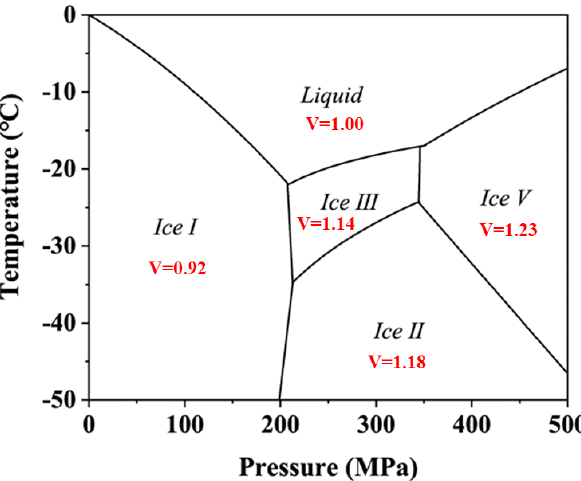
Figure 1. The volume of ice crystals (pure water) in individual phases; the letter V in the figure is the corresponding volume of different phases (g/cm 3 ). The image was drawn concerning the data of Bridgman et al. [88] and Xiao et al. [89].